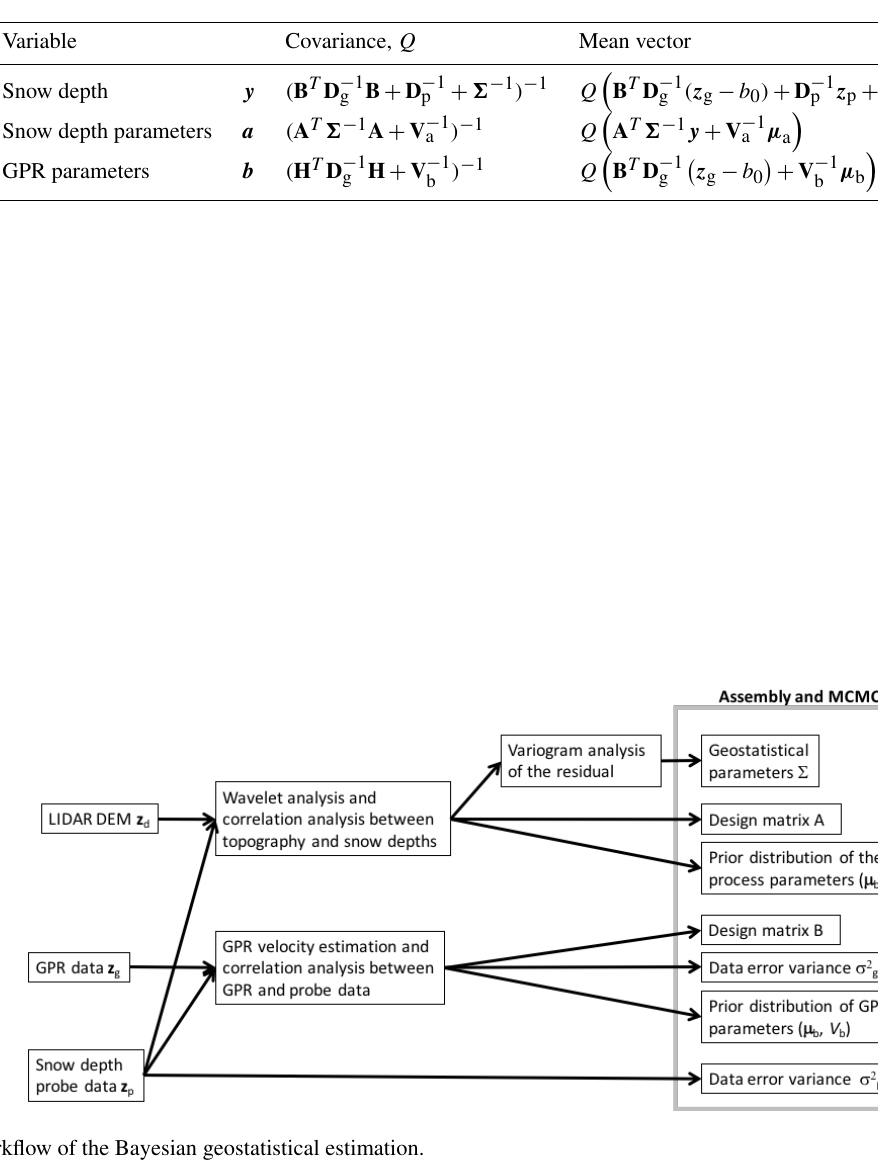
Table A1. Posterior distributions during the Gibbs sampling.